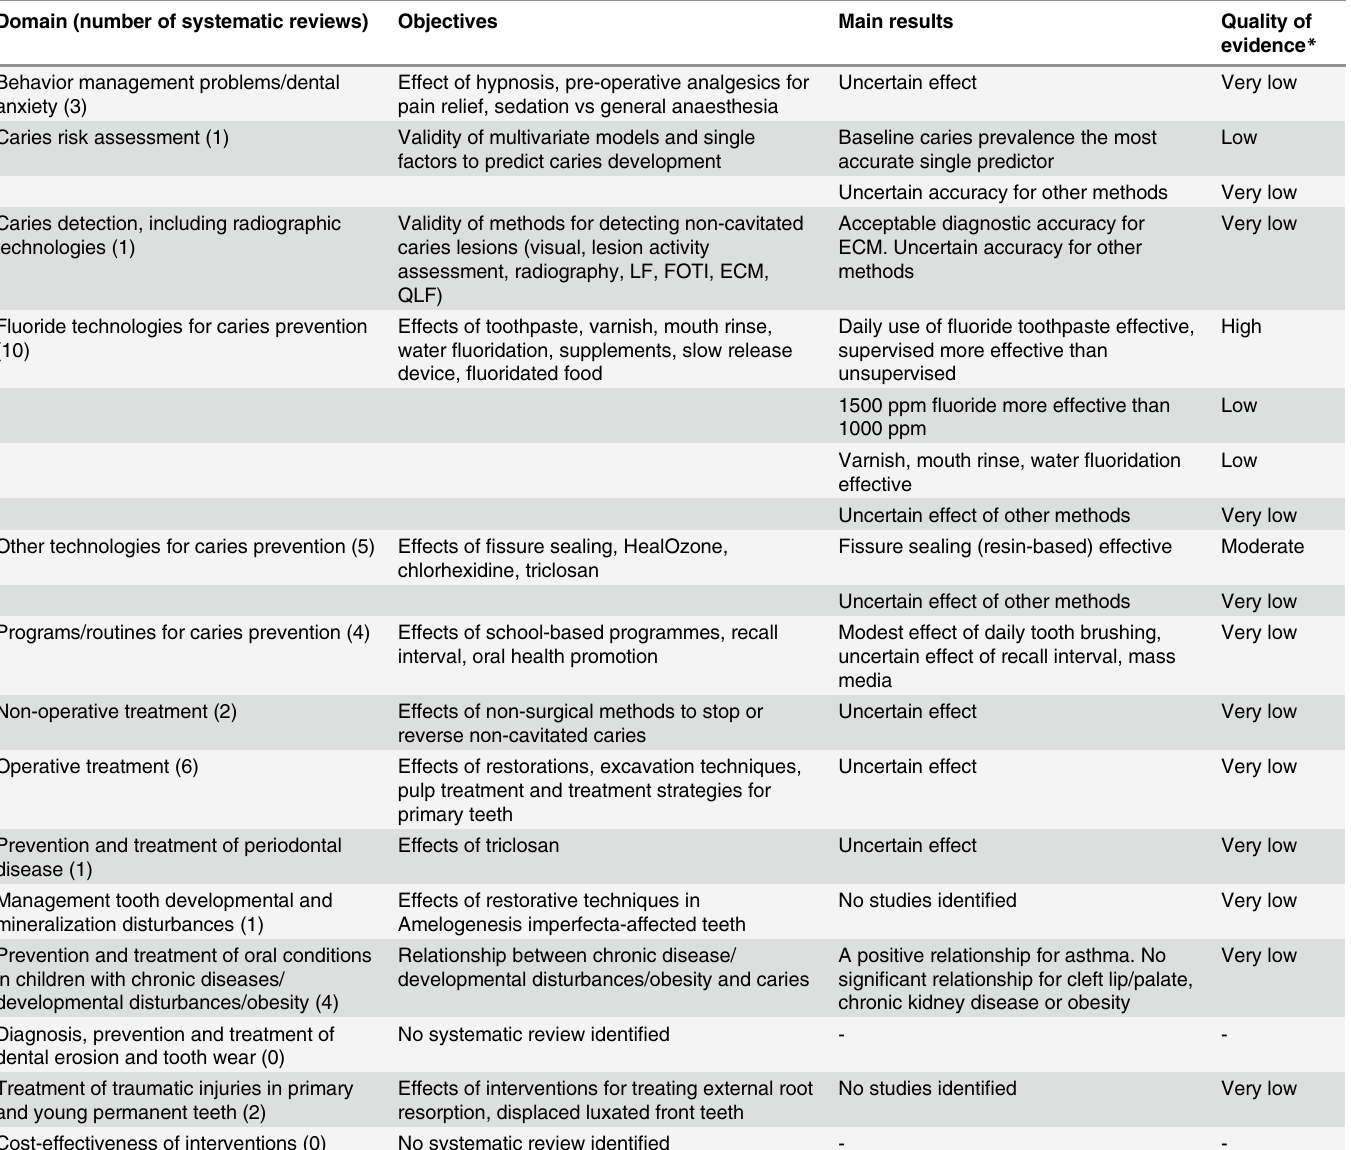
Table 3. Brief summary of systematic reviews with low or moderate risk of